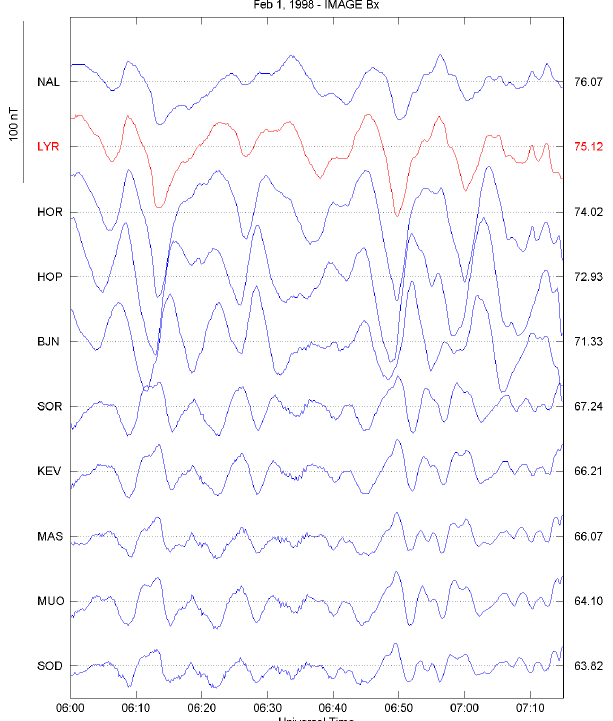
Fig. 4. X -component of the ground magnetic field between 06:00 and 07:15 UT recorded by 10 stations of the IMAGE array. For each station, its name sits on the left and its magnetic latitude (CGM) on the